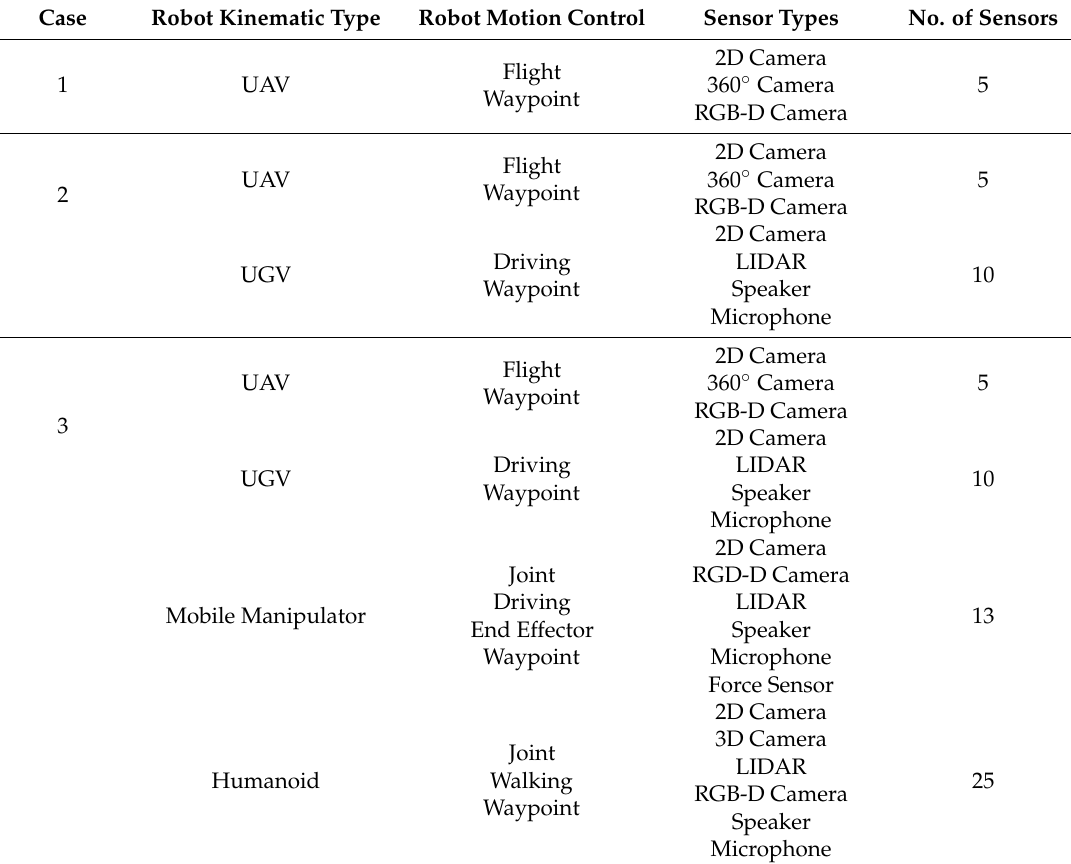
Table 2. Example test cases showing robot characteristic selections for each Robot Kinematic